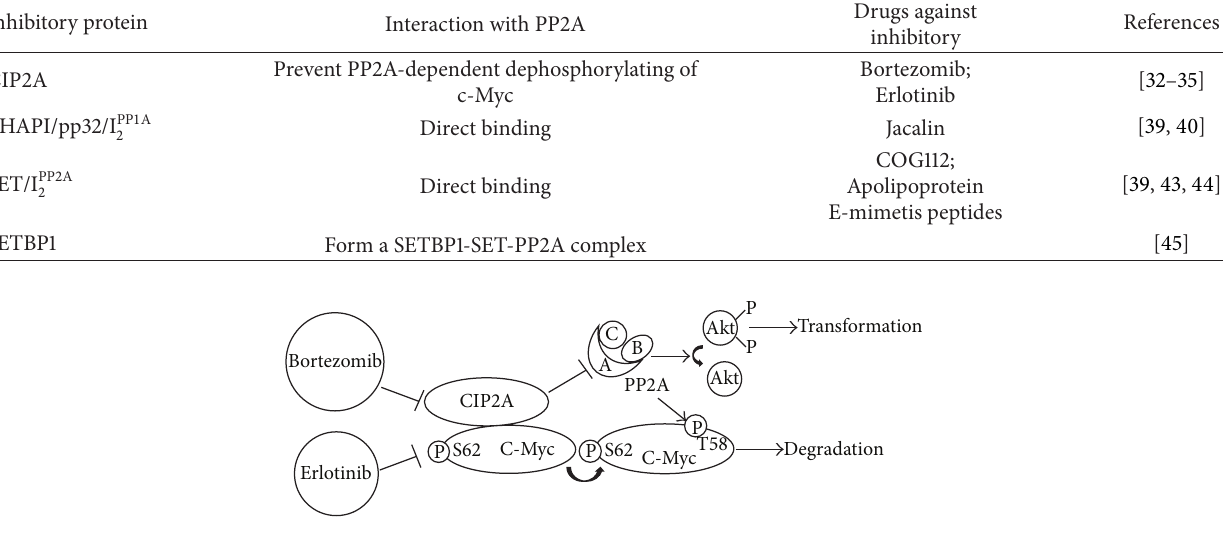
Figure 1: Bortezomib and erlotinib restore PP2A activity by targeting CIP2A. Bortezomib and erlotinib downregulate CIP2A which leads to up-regulation of PP2A activity and therefore inhibiting cell transformation by inactivating